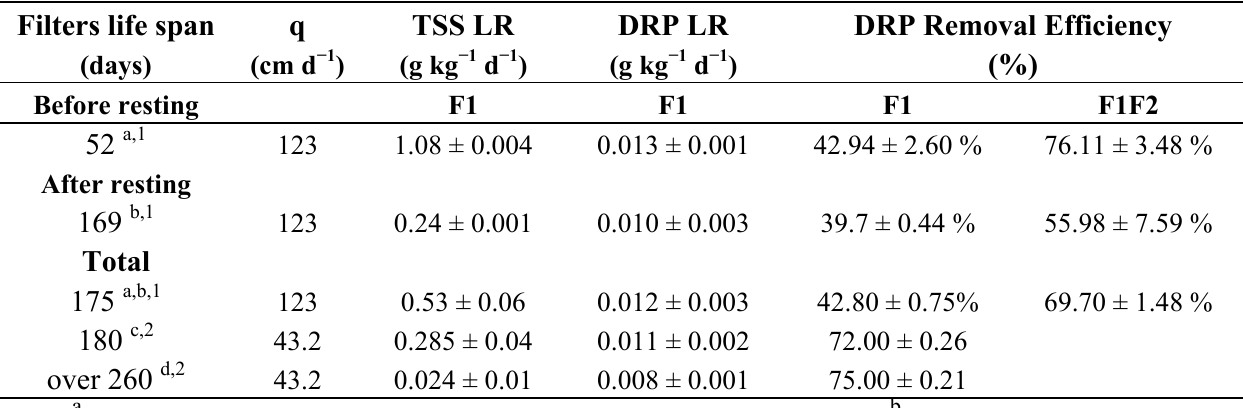
Table 1. EAF steel slag filters life span, average hydraulic loading rates (q), TSS and DRP mass loading rates and DRP removal